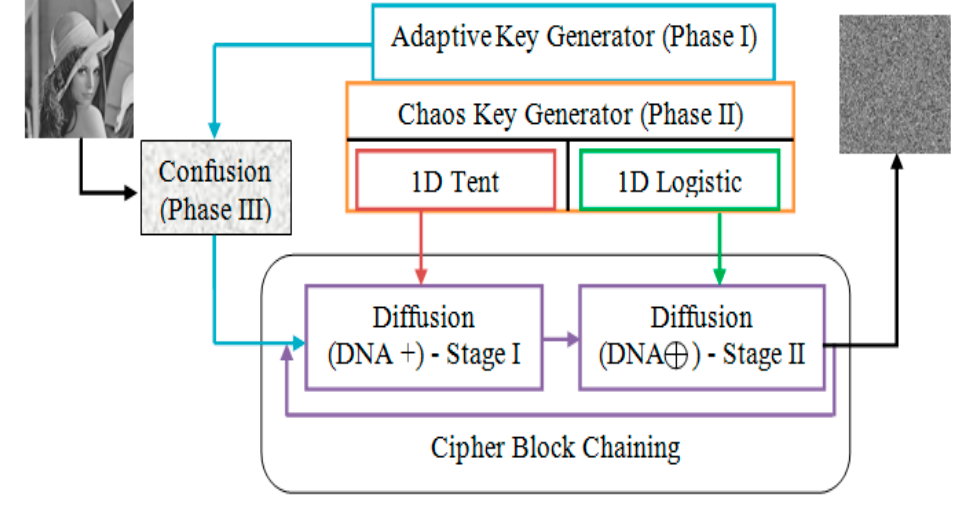
Figure 3. Proposed Security Framework.